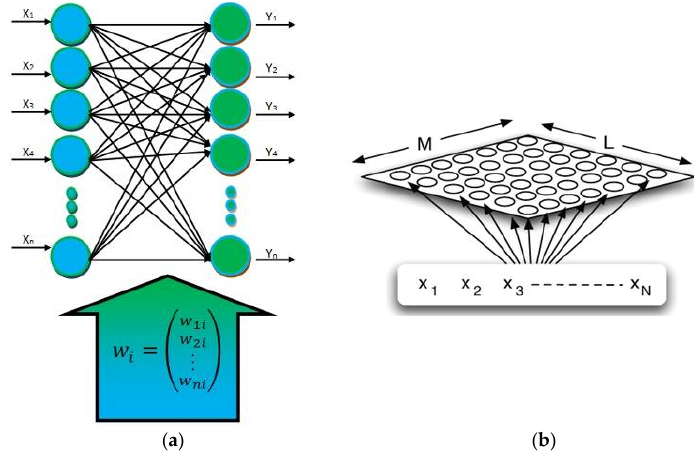
Figure 2. Model of ( a ) a one-dimensional structural model of the SOFM [35] and ( b ) a two-dimensional structural model of the SOFM [45].